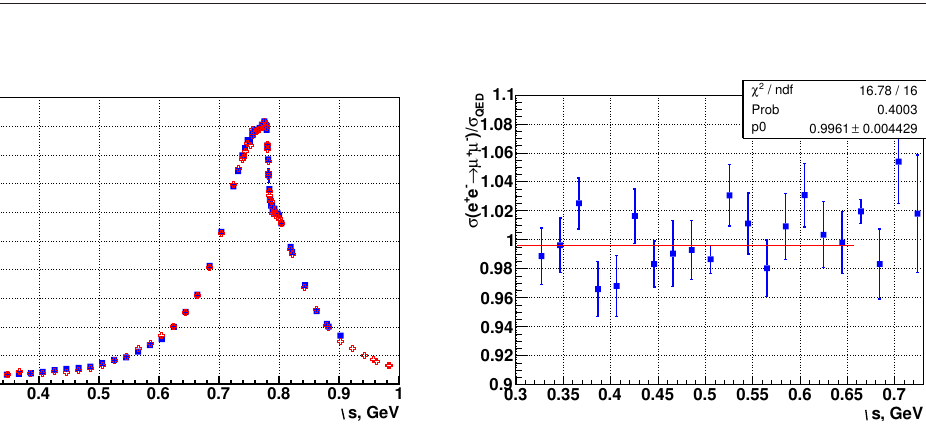
from CMD-3. Figure 5. Preliminary result of the measurement of π muon pair production in comparison with the QED